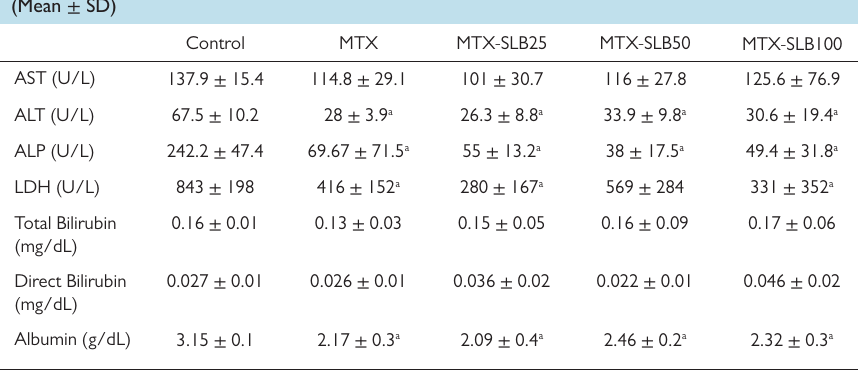
Table 4. Serum AST, ALT, ALP, LDH, Total Bilirubin, Direct Bilirubin, and Albumin Levels (Mean ± SD)